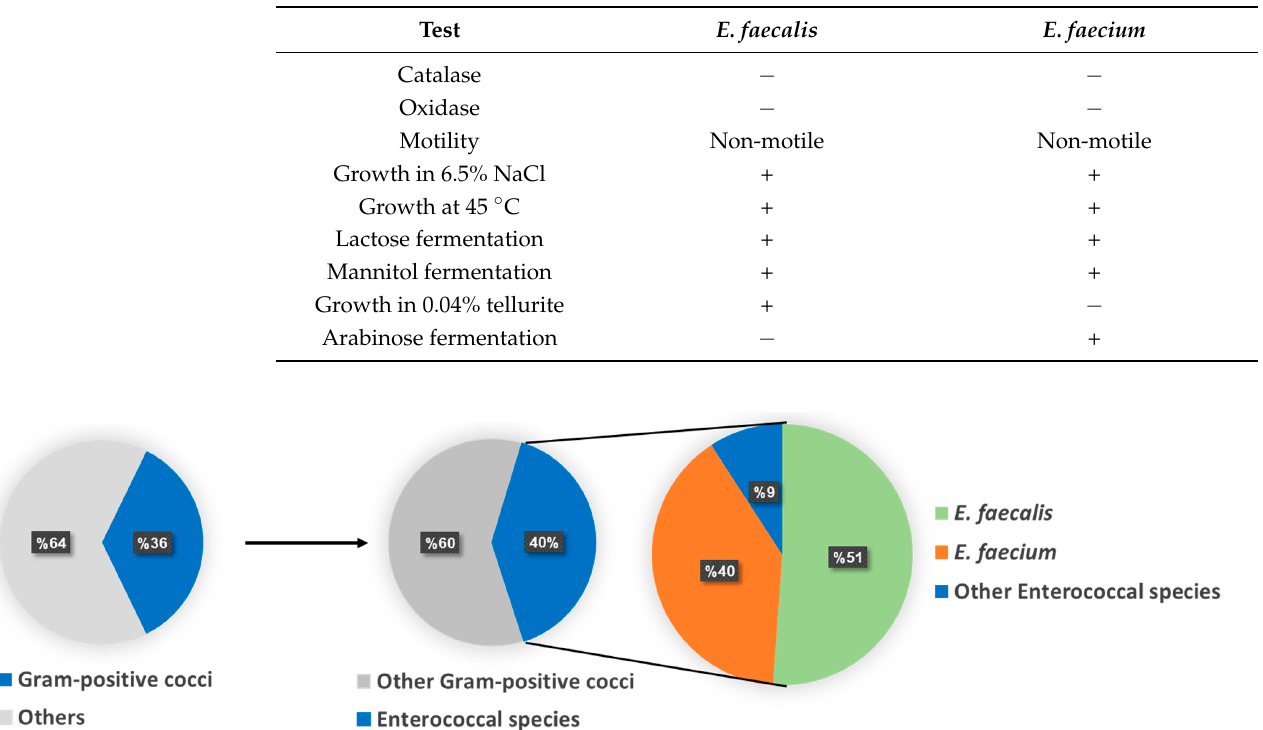
Table 1. Biochemical characterization difference between E. faecalis and E. faecium .